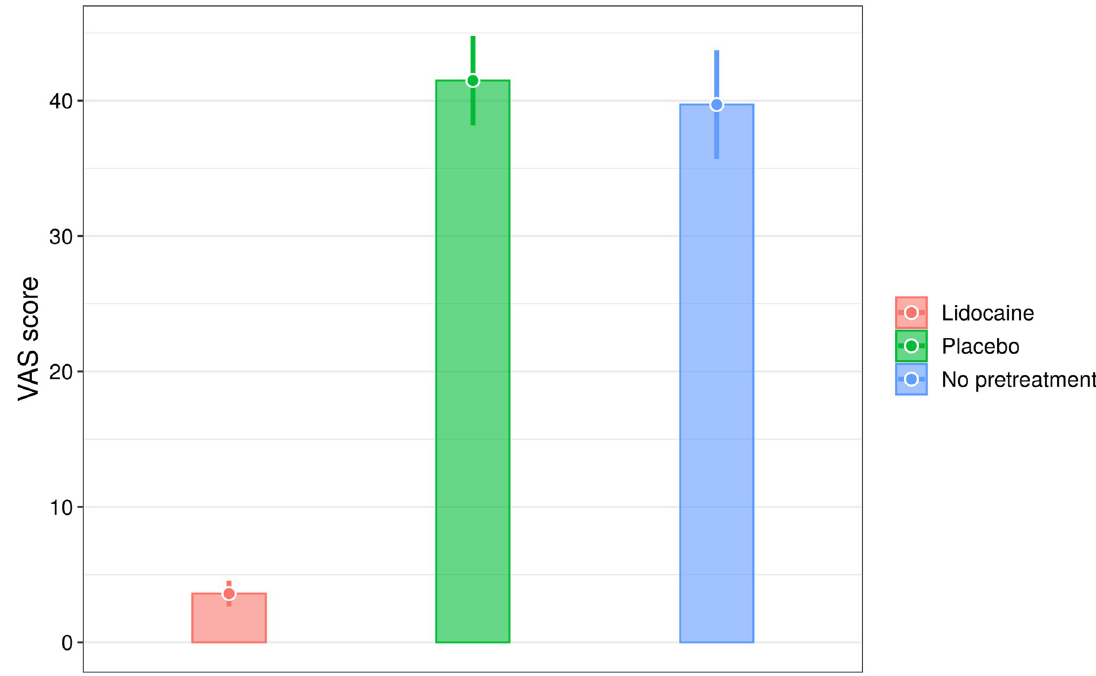
Fig 4. Mean estimates of VAS scores with corresponding 95% confidence intervals for pain experienced by the subjects after cannulations preceded by the lidocaine injection (MJ-Lido vs MJ-Saline and MJ-Lido vs No pretreatment groups (red bar), saline injection (MJ-Lido vs MJ-Saline group, green bar), or performed without any pretreatment (MJ-Lido vs No pretreatment group, blue bar).